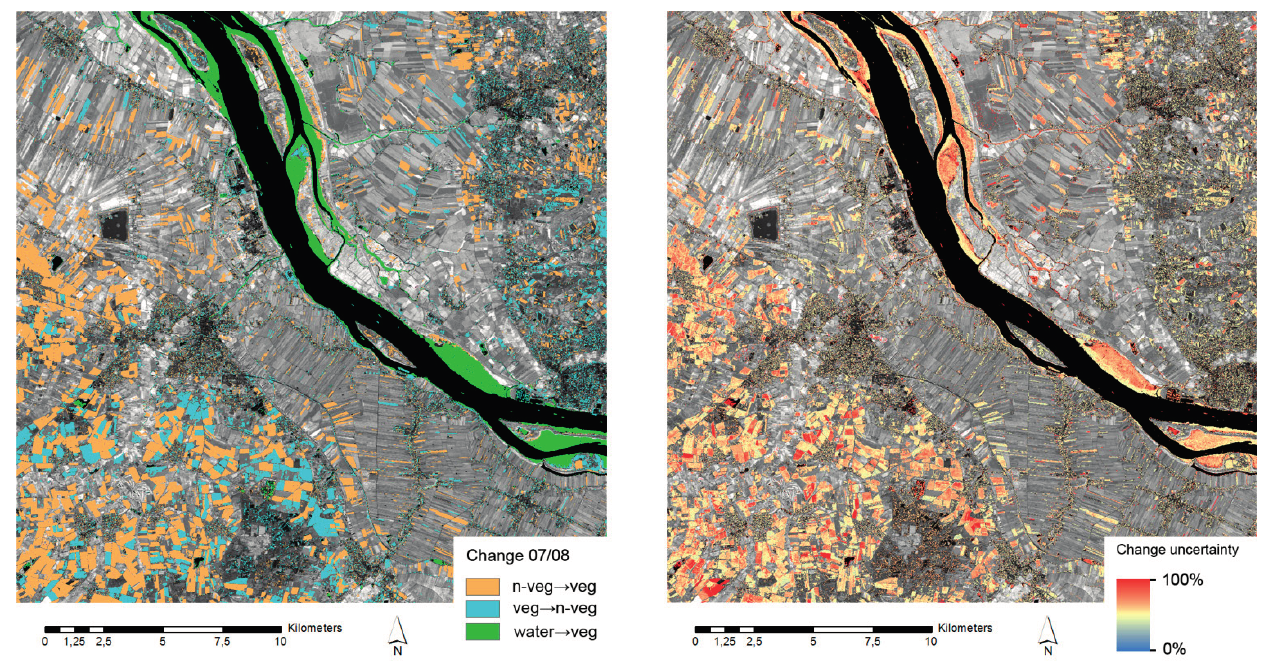
Figure 7. Change dataset ( left ) and related uncertainty ( right